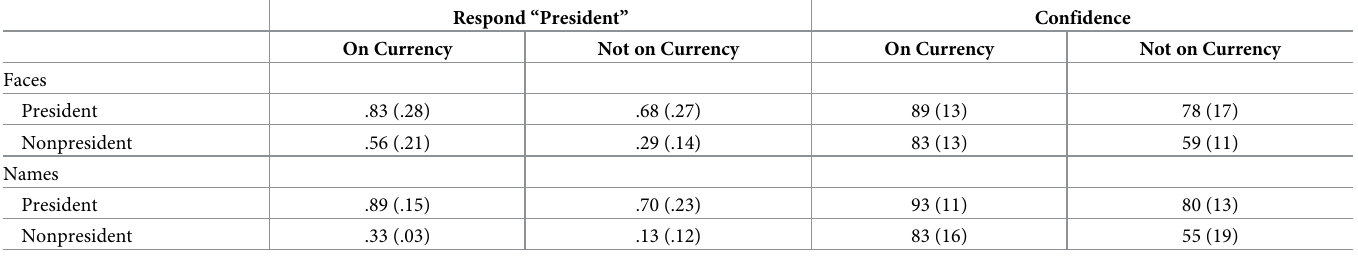
Table 7. Mean hit and false alarm rates and subjects’ mean confidence when responding “president” to a face or name in Experiment 2 as a function of whether the individual appears on US